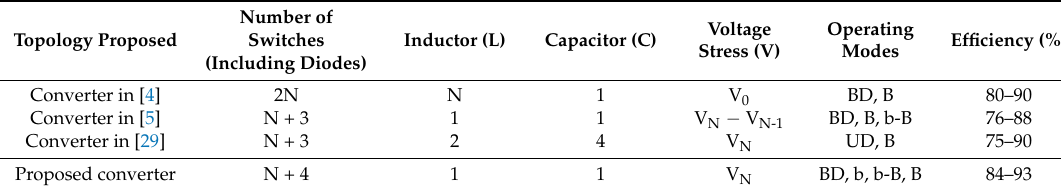
Figure 16. Efficiency versus output power of the MBDC converter. Table 4. Comparison of different multi-input DC-DC converters. UD: Unidirectional, BD: Bidirectional, B: Boost, b-B: buck-Boost, b: buck.